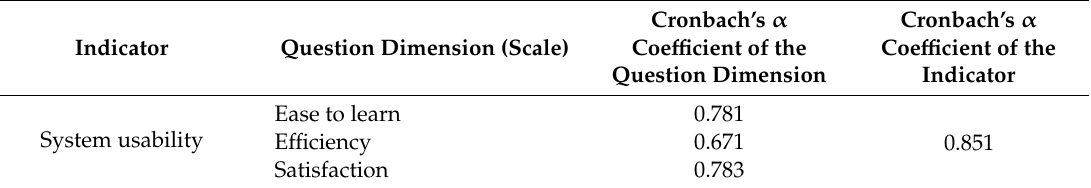
Table A7. Cronbach’s α coe ffi cients of the three question dimensions of the indicator “system usability” of the collected questionnaire data.